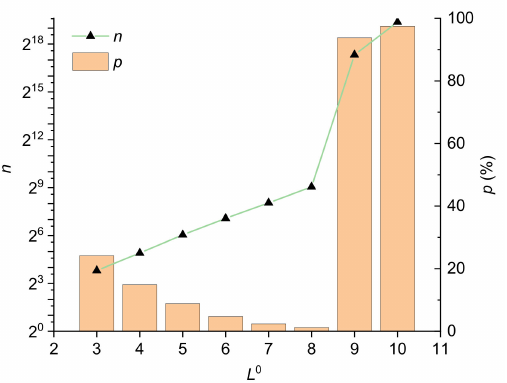
Figure 9. Number ( n ) and percentage ( p ) of the bucket files whose actual sizes are less than 4 KB.